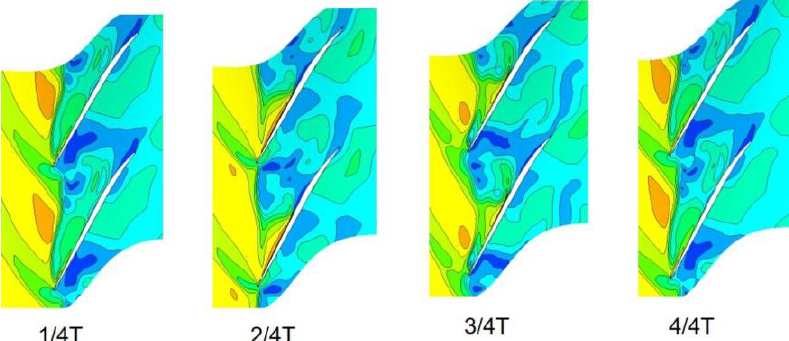
Figure 11. Mach number contours at 99% span in an unsteady period for the solid wall casing.